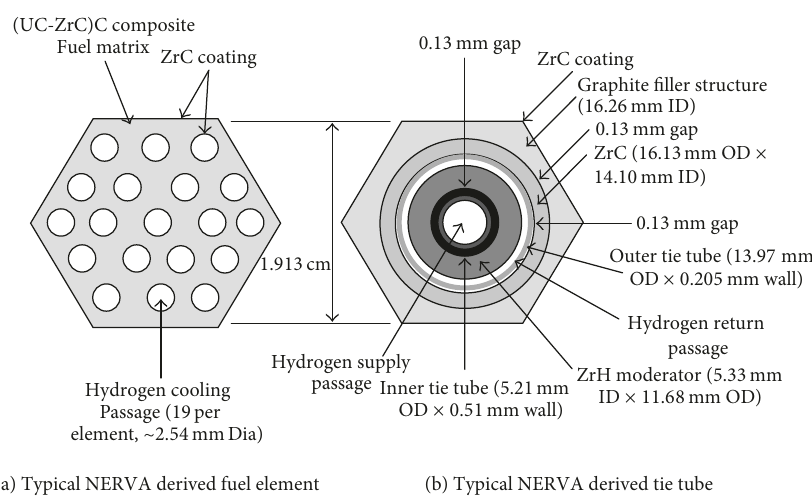
Figure 3: 19-hole fuel element and tie rod tube design of a typical NERVA engine